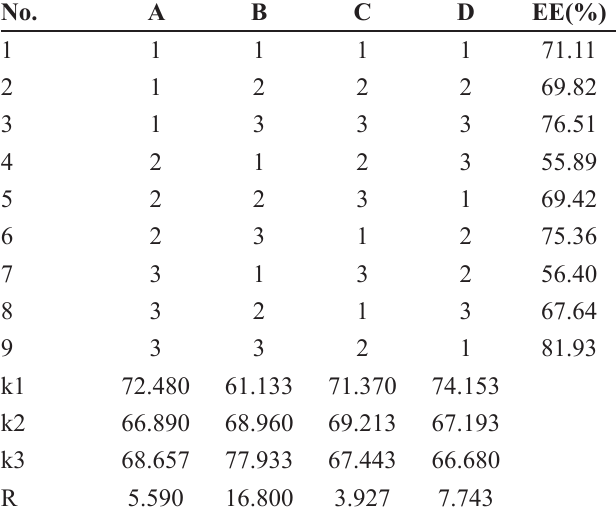
TABLE II - Results of the test of orthogonal design of TDF-